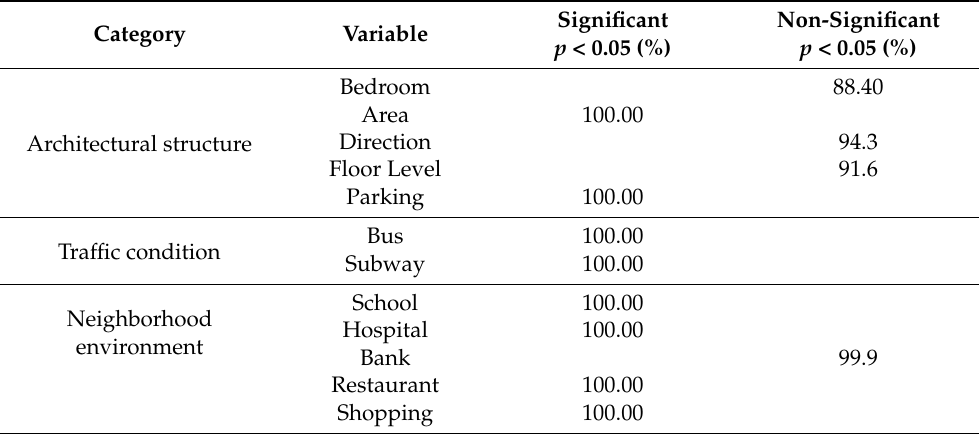
Table 9. The regression analysis results of the GWR.